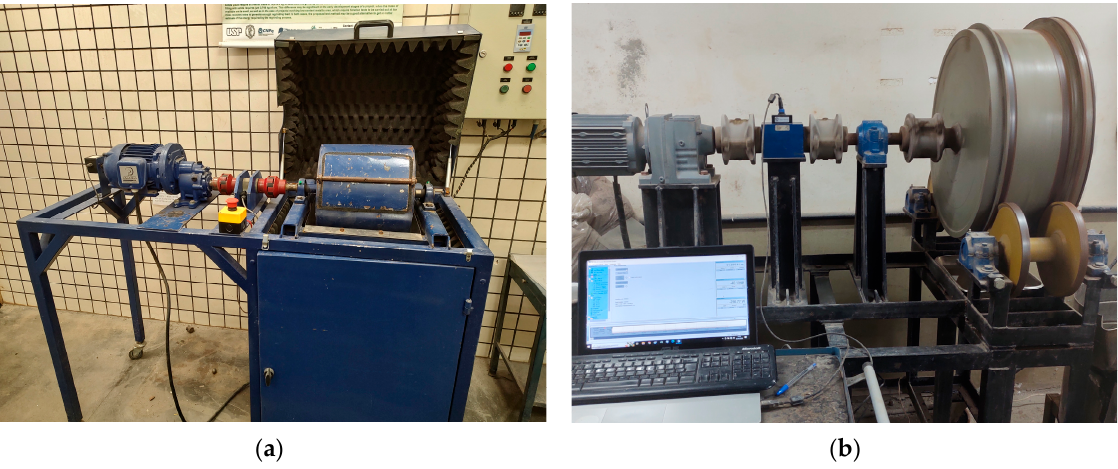
Figure 2. Test mills. ( a ) LTM-USP 305 mm × 305 mm mill; ( b ) LTM-UFRJ 580 mm × 240 mm mill. The grinding parameters are set out in Table 1. The pulp volume was such to fill the voids in the grinding media charge, which was estimated at 40% in all tests.